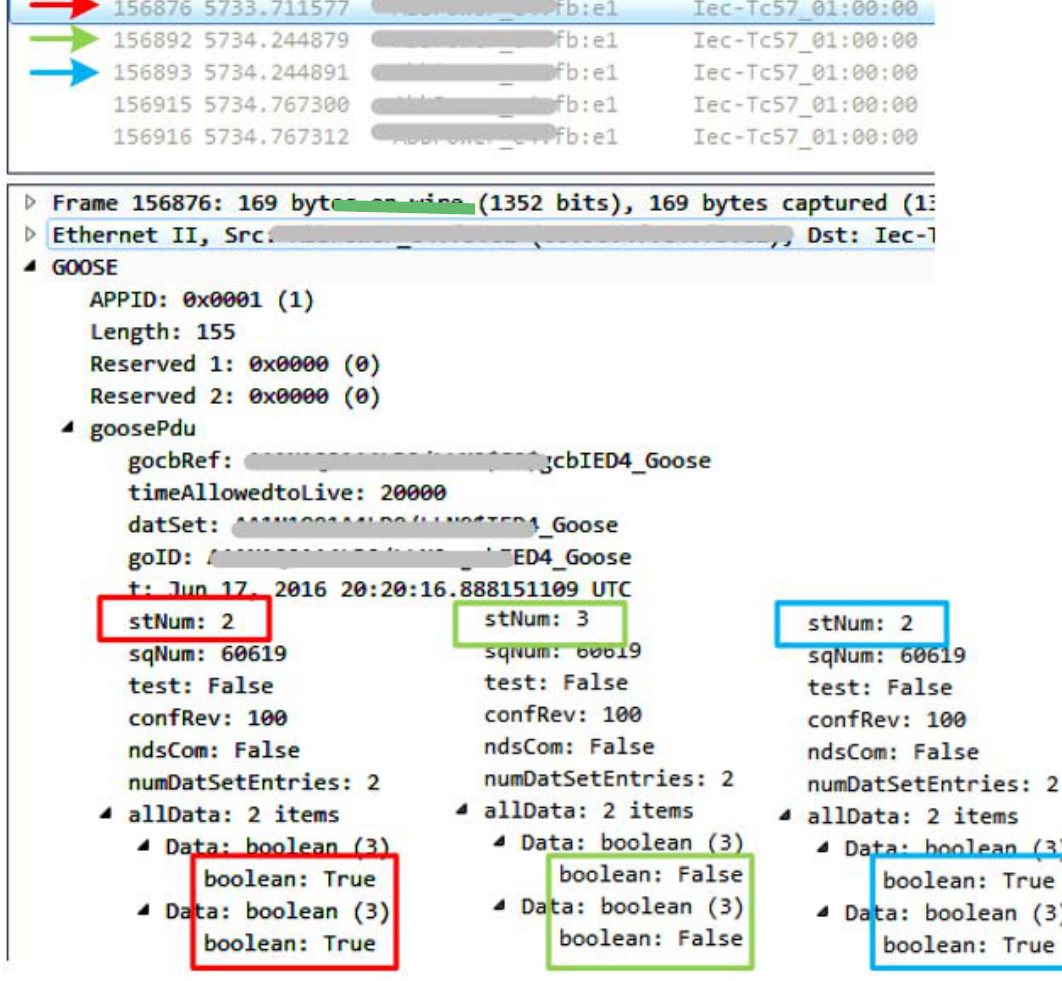
Figure 8. Wireshark Capture of Transmitted Messages (manufacturer’s details are intentionally omitted), red: original message with low status number, green: fake message with high status number, blue: original message retransmission with low status number.